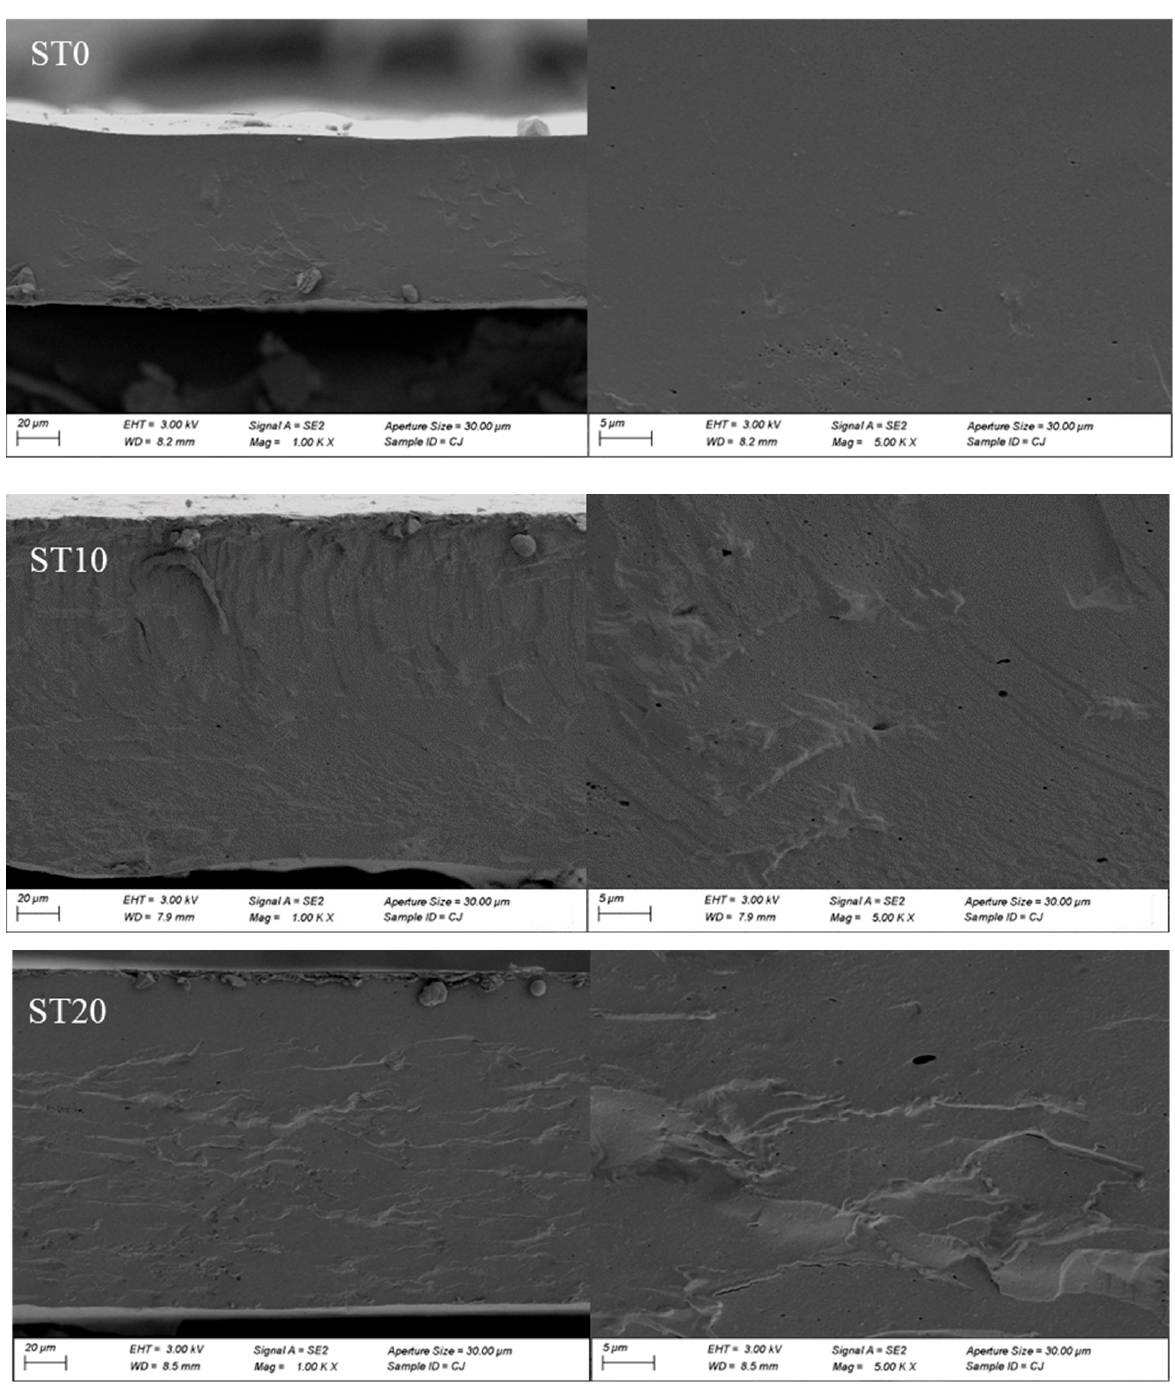
Figure 3. The SEM fractured cross-section micrographs of SPI and SPI–BT films.